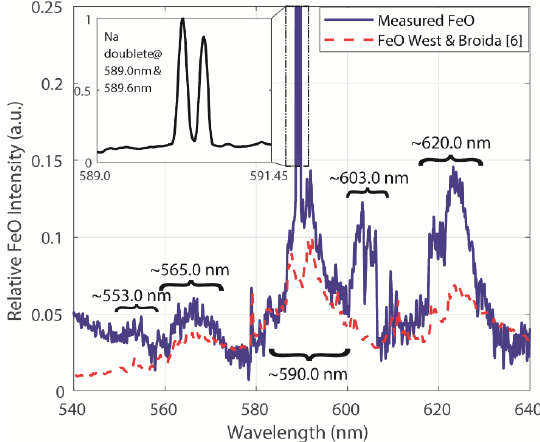
Figure 5. Spectral FeO emission measurements and reference spectral features.